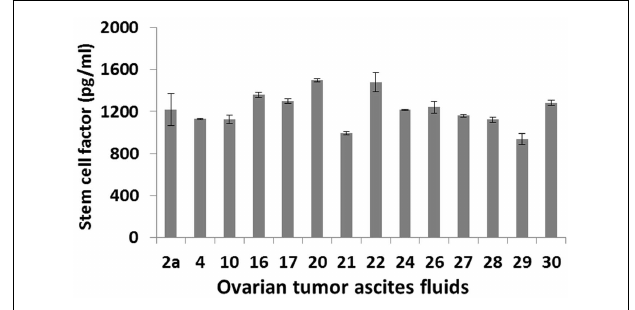
FIGURE 1 | SCF levels in primary ovarian tumor ascites fluids . Samples from 14 patients with a confirmed diagnosis of epithelial ovarian cancer were tested by